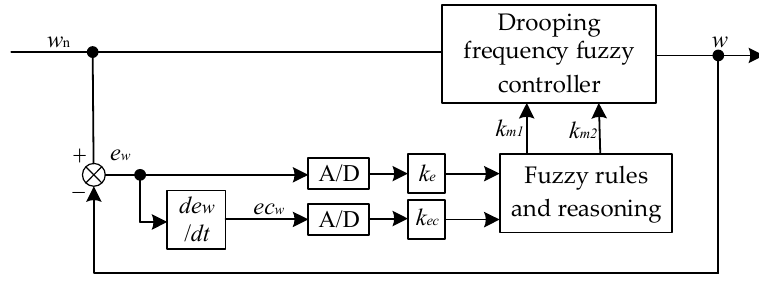
Figure 7. Frequency fuzzy droop control system diagram.